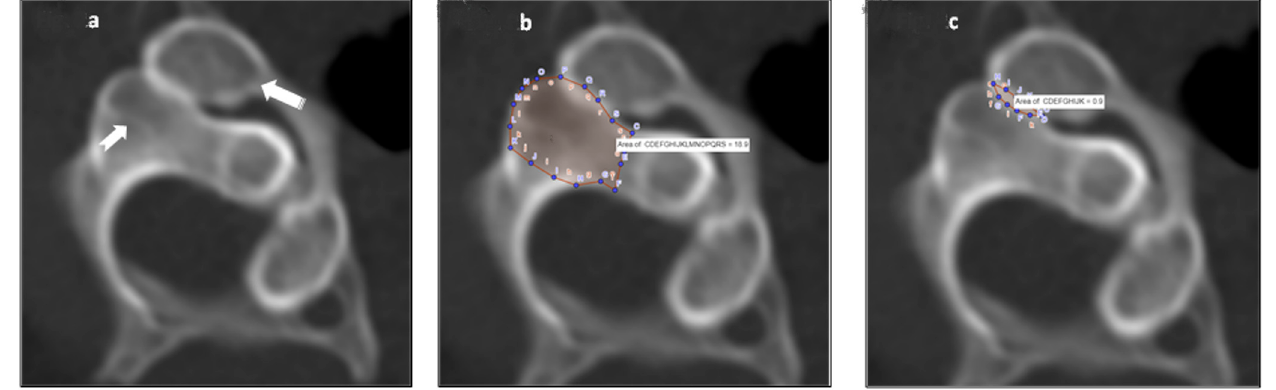
Figure 2. ( a ) CT scan, axial view, with the patient’s head rotated maximally to the left. The notched arrow points to the right superior articulating facet of C2, and the striped arrow points to the right inferior articulating facet of C1. ( b ) The same scan as in Figure 2a, with the outer margin of the right superior articulating facet of C2 outlined using the GeoGebra software, resulting in an area of 18.9 cm 2 . ( c ) The same scan as depicted in Figure 2a and b, but with the residual overlapping area of C1 and C2 outlined using the GeoGebra software, resulting in an area of 0.9 cm 2 . The area of residual overlap, as a percent of the total area of the superior articulating facet of C2, is calculated as (0.9/18.9 × 100%), and is thus 4.8%. (R—right, L—left, A—anterior,